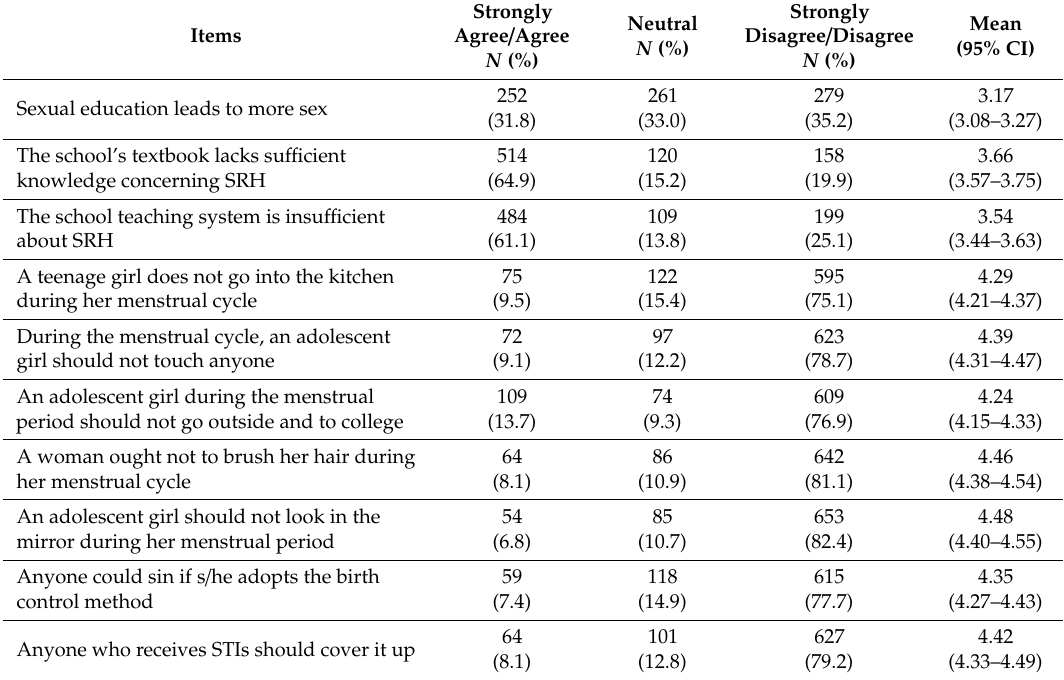
Table 3. SRH attitude-related items of older adolescent